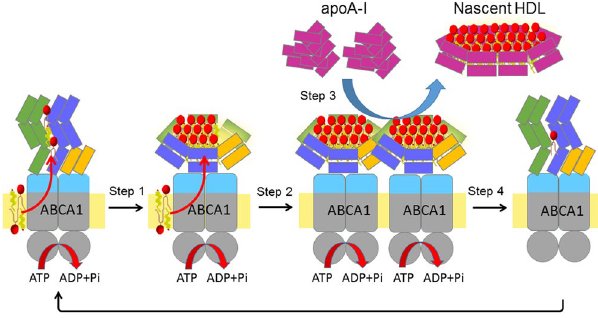
Figure 6. Schematic illustration of nascent HDL generation by ABCA1. ABCA1 monomers translocate PC and cholesterol in an ATP-dependent manner and sequester them within ECDs (Step 1). When enough PC and cholesterol have been sequestered by the ECDs, the ECDs undergo conformational changes that lead to dimer formation and to the halting of their diffusive movement (Step 2). Lipid-free apoA-I molecules may bind directly to the ECDs of ABCA1 dimers (Step 3), and become loaded with lipids sequestered within the ECDs. Nascent HDL is generated and the ABCA1 dimer dissociates into monomers upon releasing the sequestered lipids (Step 4), thereby returning to Step